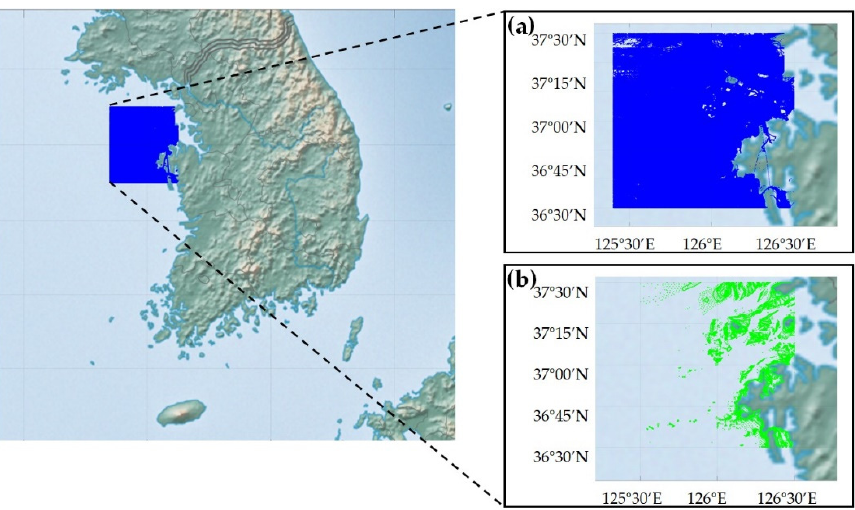
Figure 2. Spatial information obtained from the AIS and ENC data: ( a ) AIS data points in the selected area, ( b ) Distribution os ENC data points in the selected area.